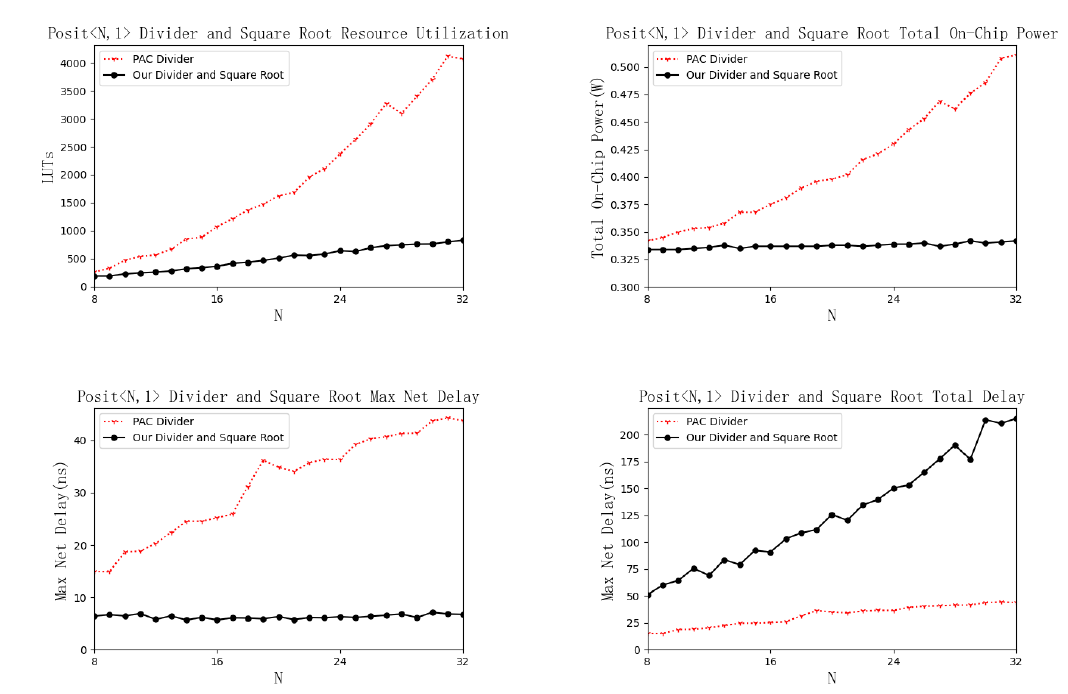
Figure 6. Posit<N,1> divider and square root implementation